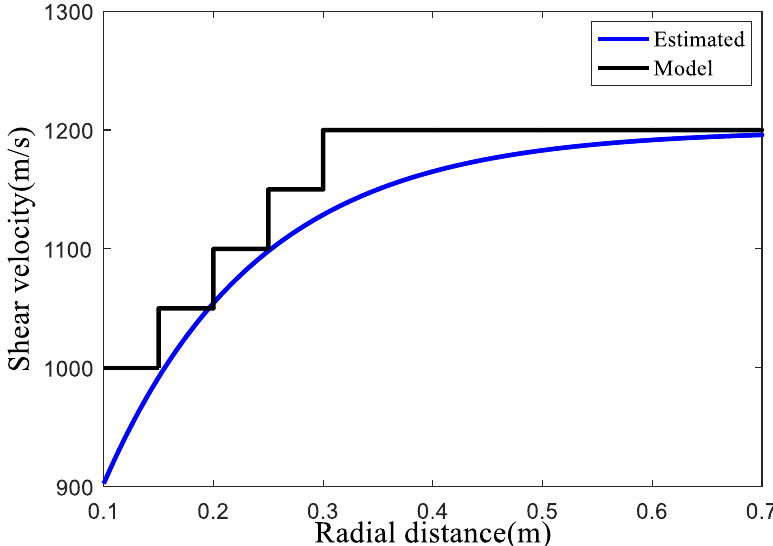
Figure 5. Inversion result of high-frequency constrained inversion method.